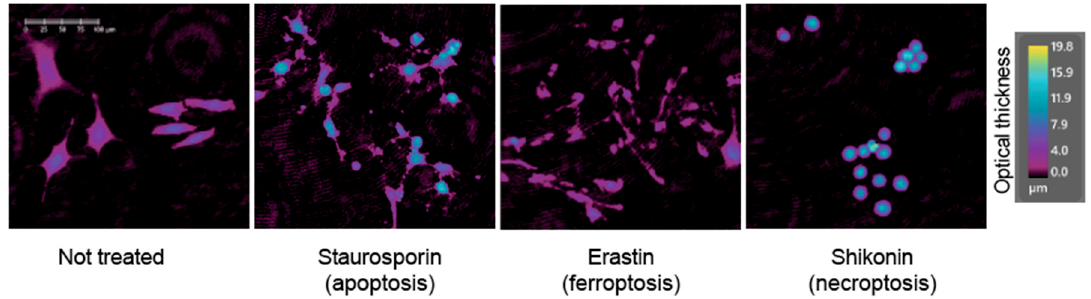
Figure 3. Digital holographic cytometry (DHC) images of indicated conditions. Expected form of programmed cell death indicated in parentheses.